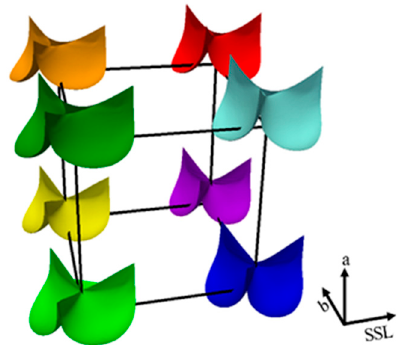
Figure 3. The extreme leaflet shapes visualized in the space of valve design parameters.